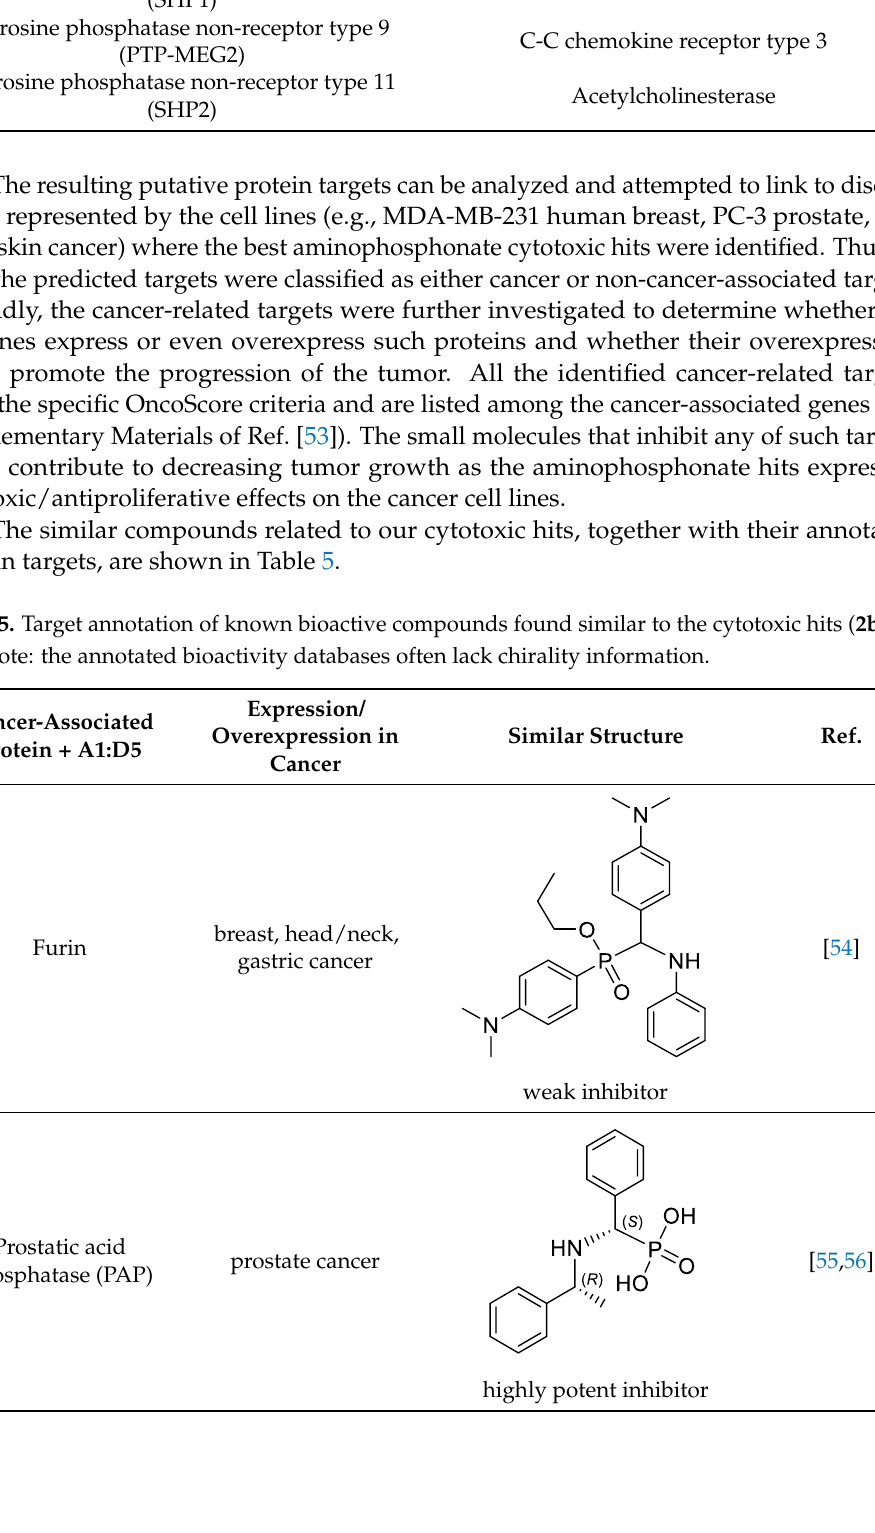
Table 4. Classification of the putative protein targets of the cytotoxic hit compounds ( 2b , 2d , 2e ).